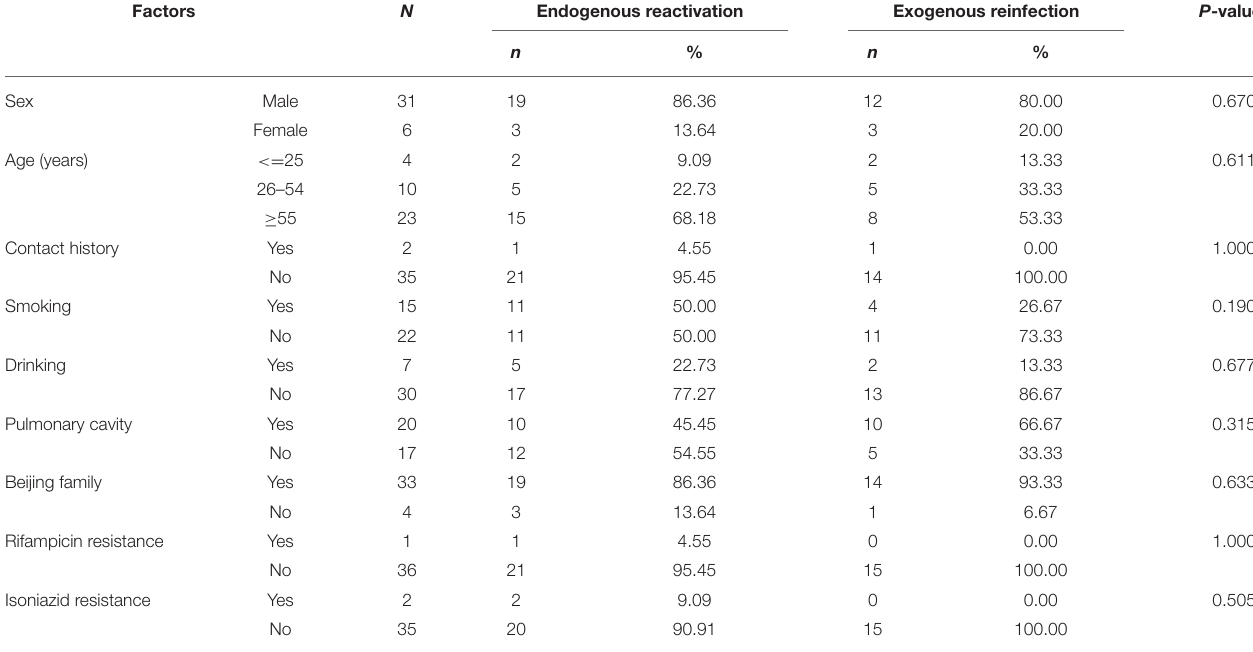
TABLE 4 | Comparison of the characteristics between endogenous reactivation and exogenous reinfection. Factors